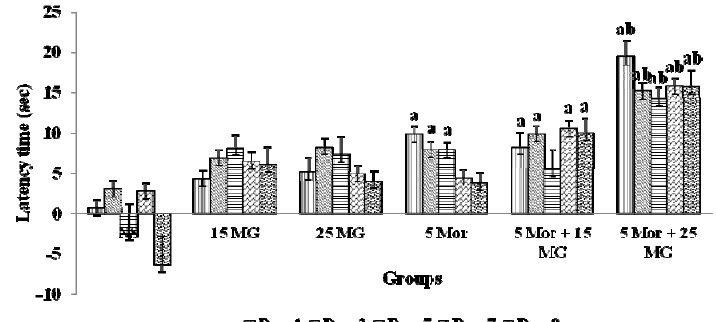
Figure 2. The effects of control group [Normal saline (NS), mitragynine (MG) (15 mg/kg, 25 mg/kg], morphine (5 mg/kg) and combination groups (5 mg/kg Mor + 15 mg/kg MG; 5 mg/kg Mor + 25 mg/kg MG) on latency time using hot-plate test for 9 days treatments. Each column represents the mean ± SEM of latency time (s) of seven animals in each group. Values are statistically siginficant at p < 0.05. a: Morphine and combination treated groups when compared with control group and b: Combination treated group when compared with morphine alone ( p < 0.05).